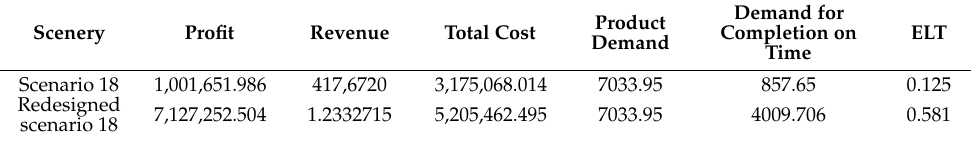
Table 7. Performance comparison.